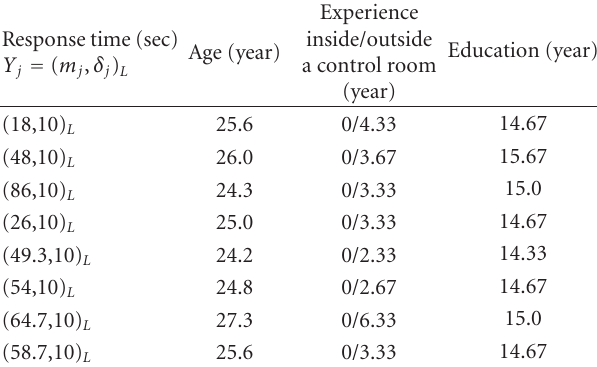
Table 2: Fuzzy parameters of LOCA accident of Chinese NPP